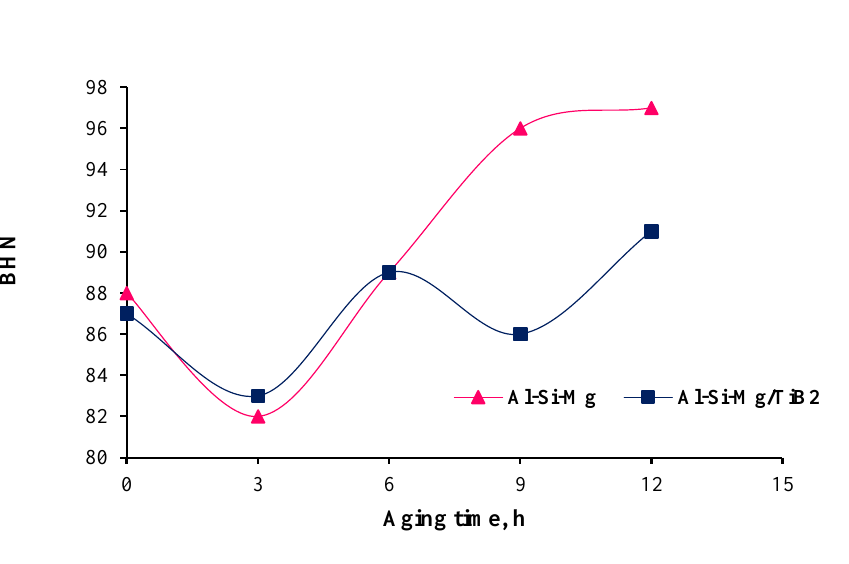
Fig. 6. Effect of aging time on BHN, base alloy (Al-Si-Mg) and Composite (Al-Si- Mg/TiB 2